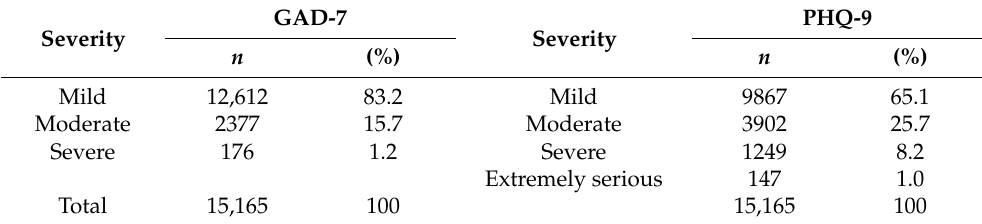
Table 1. The severity of depression and anxiety in patients during